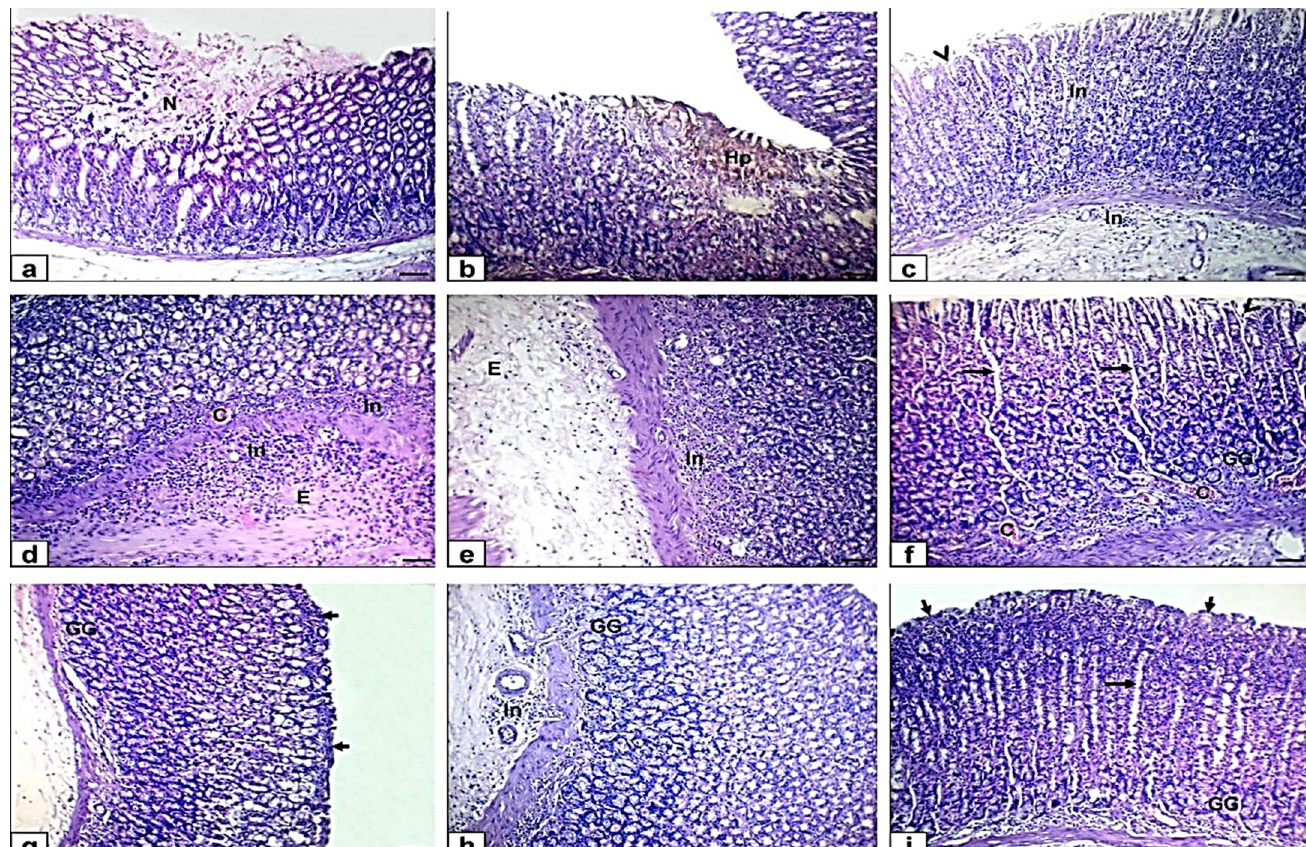
Figure 3. Photomicrographs of gastric sections stained with H&E in ethanol and ethanol-treated groups with myrrh extract (EtOH-ME) and myrrh oil (EtOH-MO). ( a – e ) Ethanol-induced ulcer in rats on day 7 showing moderate coagulative necrosis (N), old hemorrhages and brown hemosiderin precipitation (Hp), disruption to the surface epithelium (arrowhead), mononuclear cells infiltration and aggregation (In) in all layers of gastric mucosa, and moderate edema (E) in the submucosa. ( f , g ) MO treated rat showing dilated and wide gastric pits (long arrows), dilated congested blood vessels (C), and disruption to the surface epithelium (arrowhead). ( h , i ) ME-treated rat showing mild mononuclear cell infiltration (In), dilated gastric pits (long arrows), and intact appearance of histological structure of the epithelium (short arrows), gastric gland (GG) and mucosa layer. Scale bar = 100 µm.